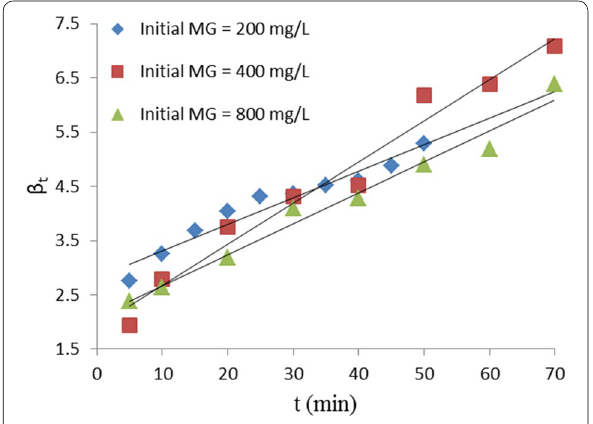
Fig. 10 Boyd plot for removal of MG by TLLP